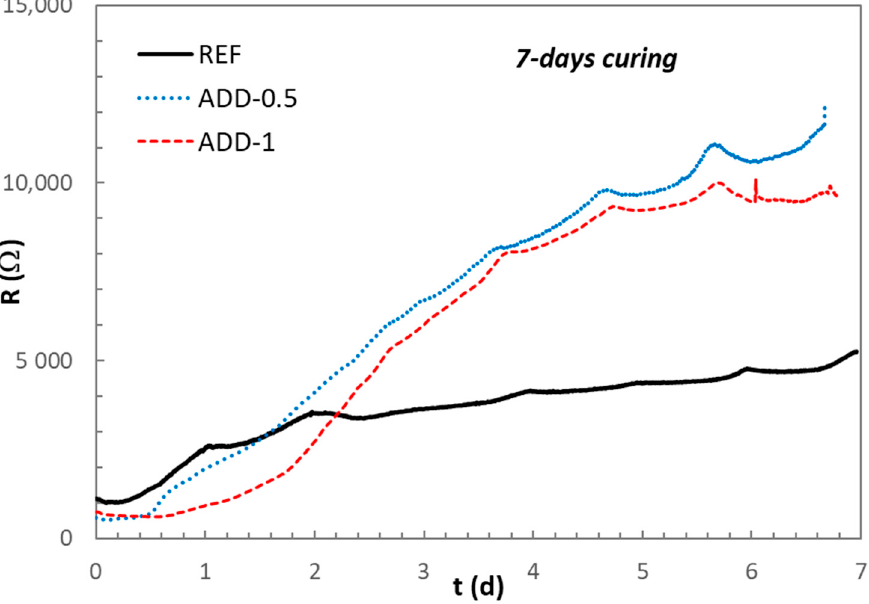
Figure 8. Evolution of the electrical resistance of the different mortars during the first 7 days curing in chamber at 98% relative humidity. in chamber at 98% relative